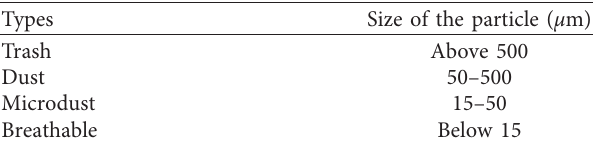
Table 1: Size of cotton dust particles